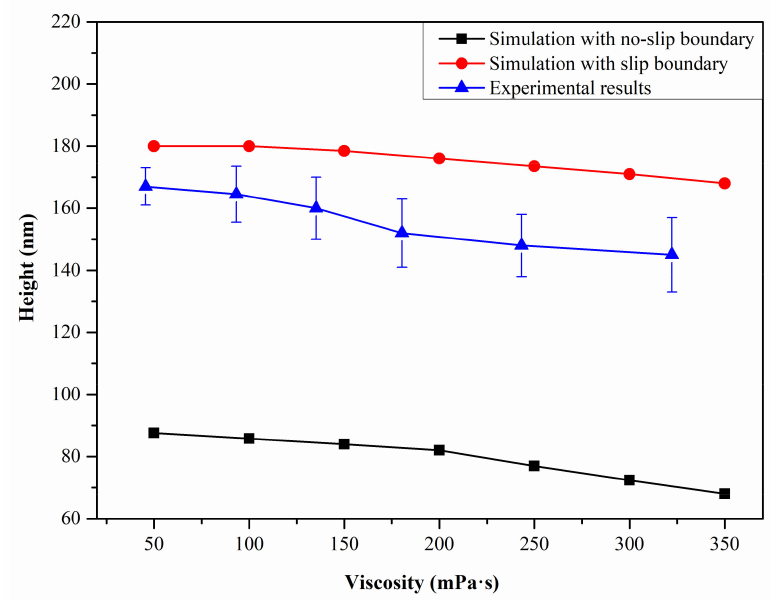
Figure 7. Effect of resin viscosity on the filling height of moth-eye nanostructure.